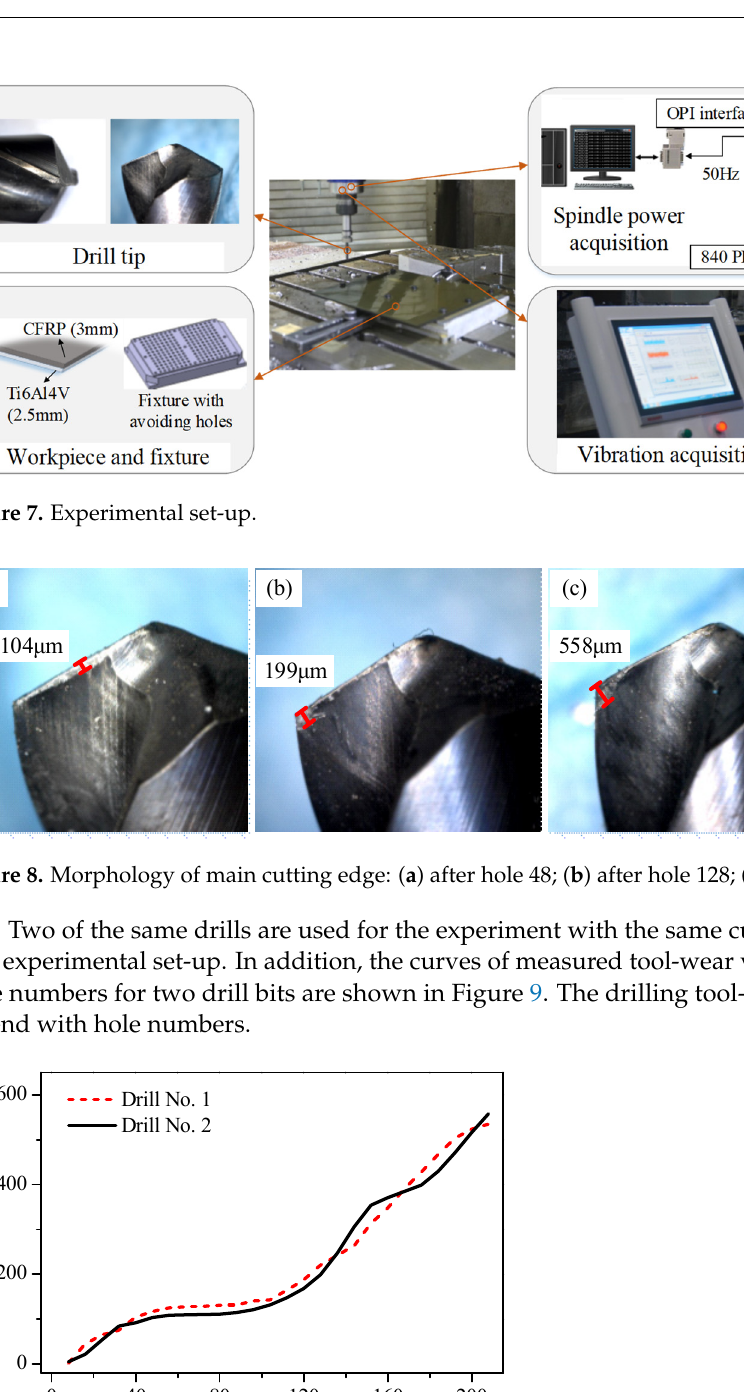
Figure 8. Morphology of main cutting edge: ( a ) after hole 48; ( b ) after hole 128; ( c ) after hole 208. Two of the same drills are used for the experiment with the same cutting parameters and experimental set-up. In addition, the curves of measured tool-wear values vs. drilling hole numbers for two drill bits are shown in Figure 9. The drilling tool-wear values both ascend with hole numbers.